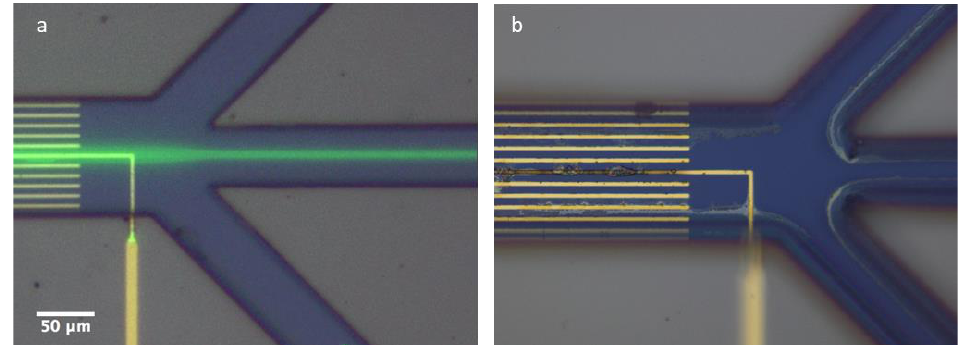
Figure 10. ( a ) Eighty-four-nanometer PS particles focused towards the center of the channel and directed towards the center outlet. Flow speed 50 µL/h at 2 V. ( b ) After prolonged (hours) exposure to 2 V potential, the center gold electrodes showed a significant amount of degradation/dirt accu- mulation.